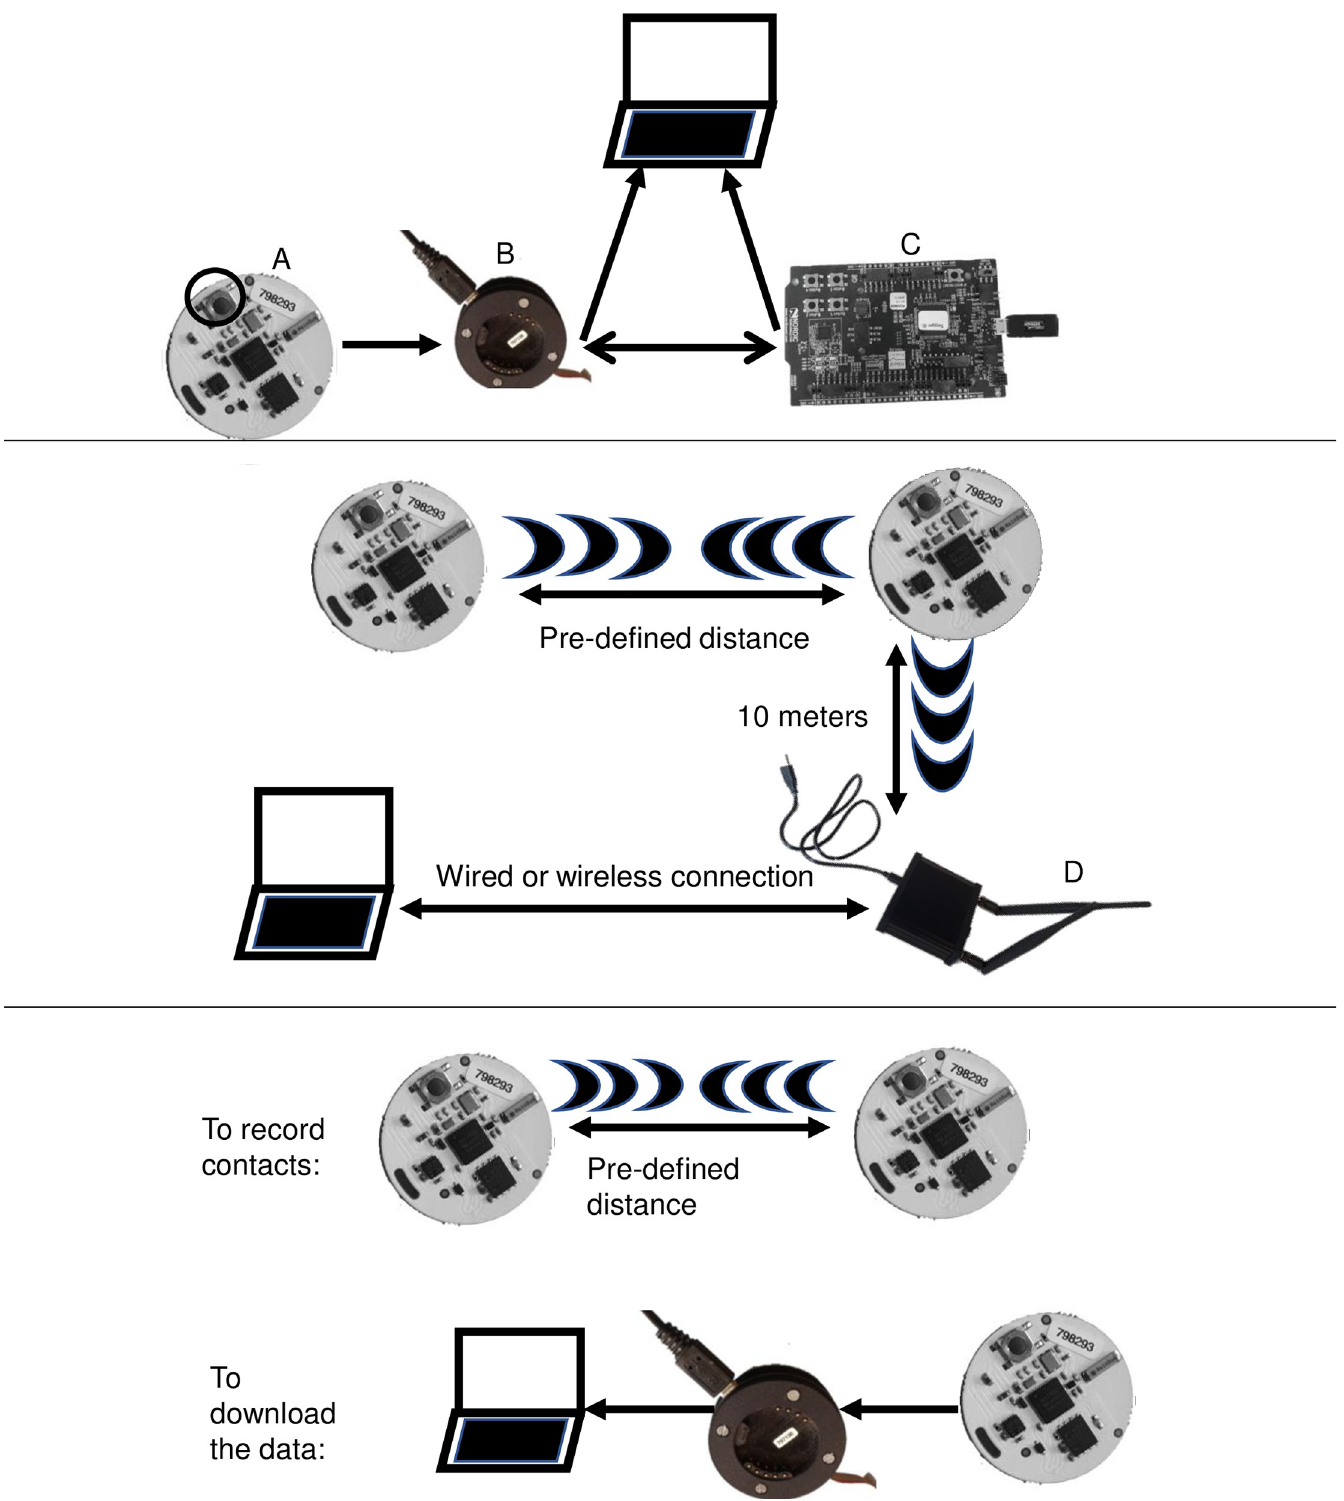
Fig 2. The RFID tag system and components. The top panel shows the components used to flash the tags. The components required to flash a tag are: a computer, a tag (labelled A), a programmer-device (labelled B), and a Nordic board (labelled C). The middle panel shows the traditional RFID setup. In addition to a computer and tag, the communicating tags must be within 10 m of the reader (labelled D) in order to transmit the data to the computer. The bottom panel depicts the modified system, in